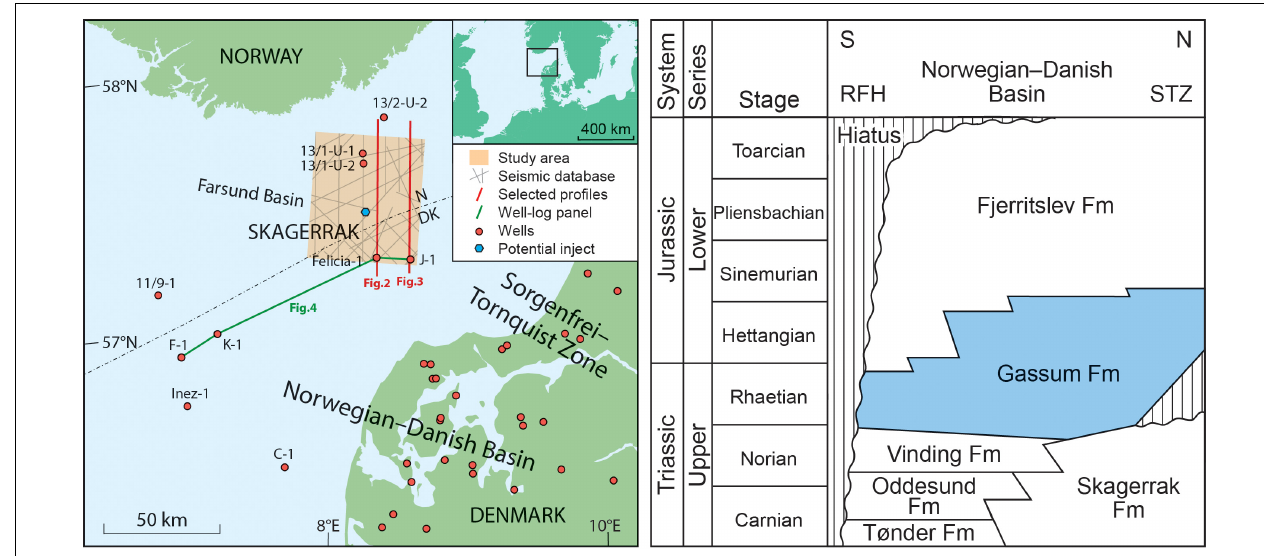
FIGURE 1 | The studied part of the Gassum Formation is located in the Skagerrak in the Norwegian-Danish Basin. The stratigraphic scheme depicts the basin from the Ringkøbing-Fyn High (RFH) to the Sorgenfrei-Tornquist Zone (STZ). The stratigraphy is based on Michelsen and Clausen (2002) and Nielsen (2003).